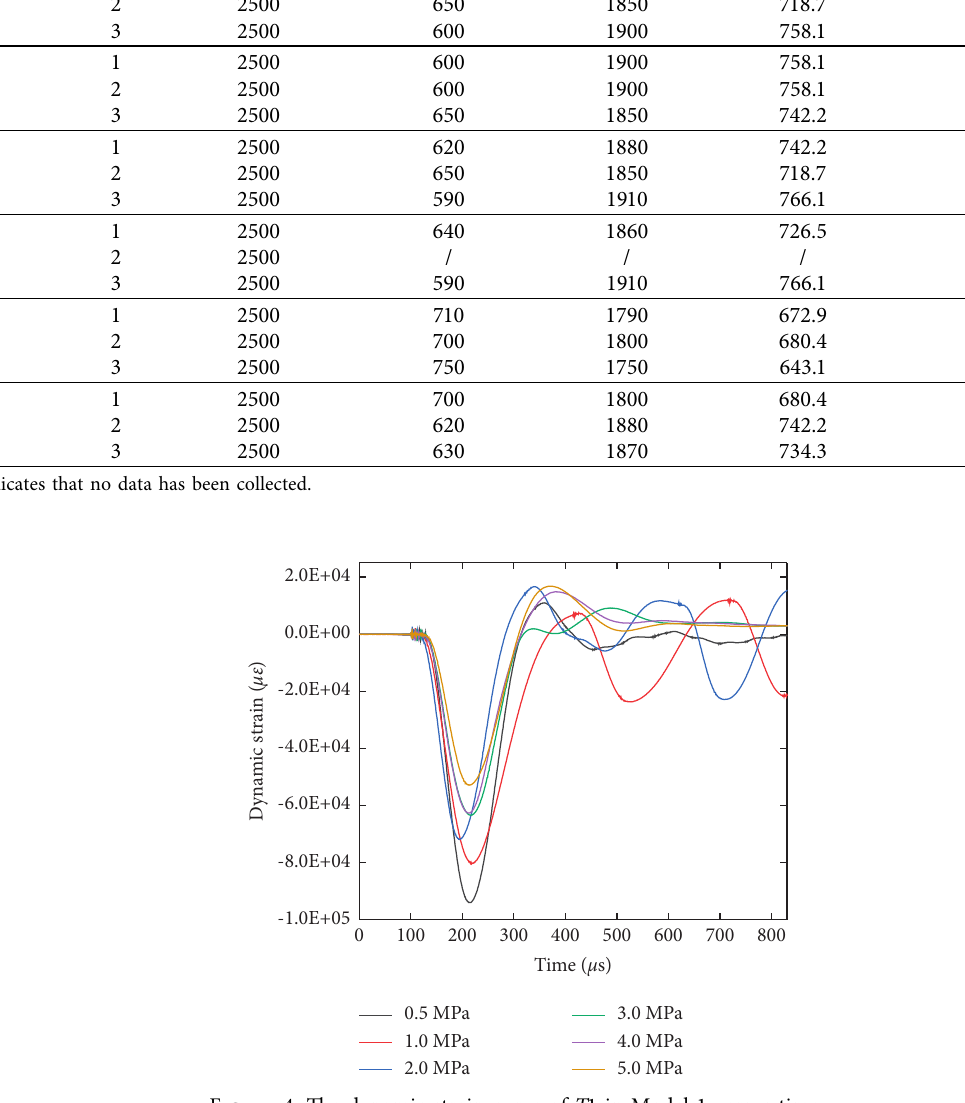
Figure 4: The dynamic strain curve of T 1 in Model 1 versus